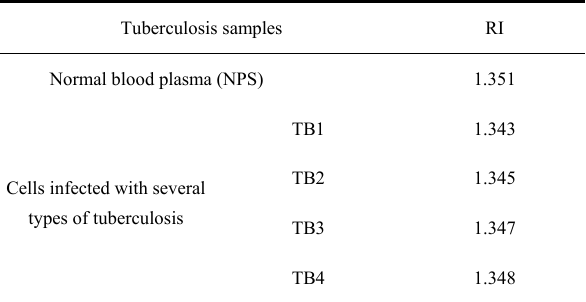
Table 2 RIs of cells infected with several types of